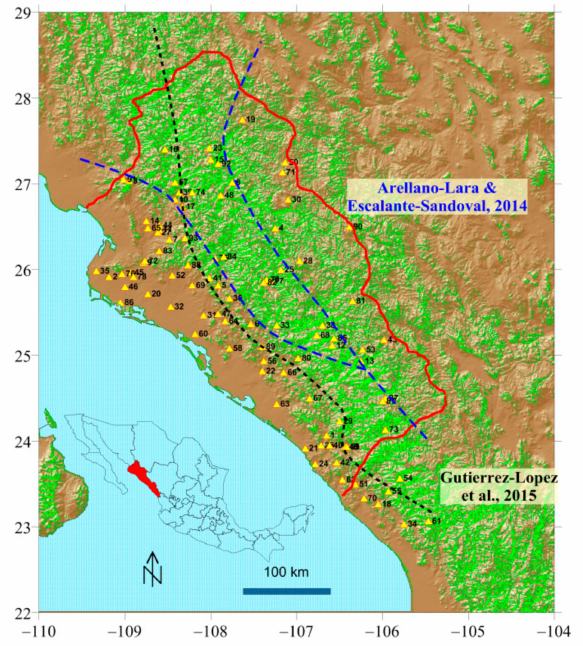
Figure 3. Regionalization proposed by Arellano-Lara and Escalante-Sandoval (2014) [39] and Gutierrez-Lopez et al. (2015)